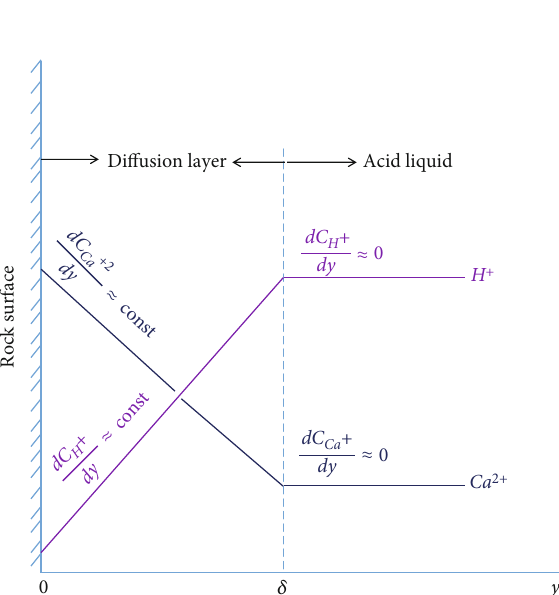
Figure 8: Retarded test of composite and conventional mud acid.